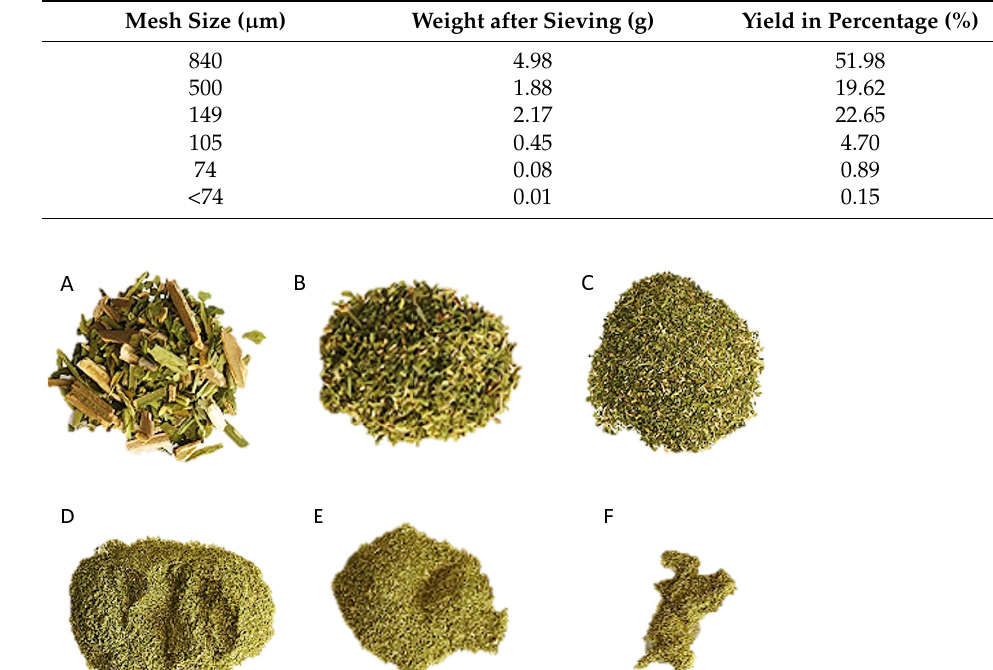
Table 2. Nicotiana tabacum var. Virginia. Sieved fractions from ground leaf waste. Mesh Size (µm) Weight after Sieving (g)